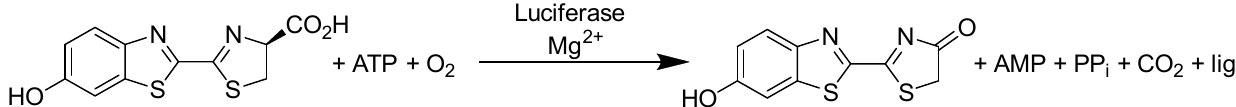
Figure 2. Design of the Cx43 GJ assay. HeLa cells expressing A 2A AR and Cx43 are denoted as do ‐ nor cells and HeLa cells expressing GloSensor luciferase and Cx43 as biosensor cells. The cell lines